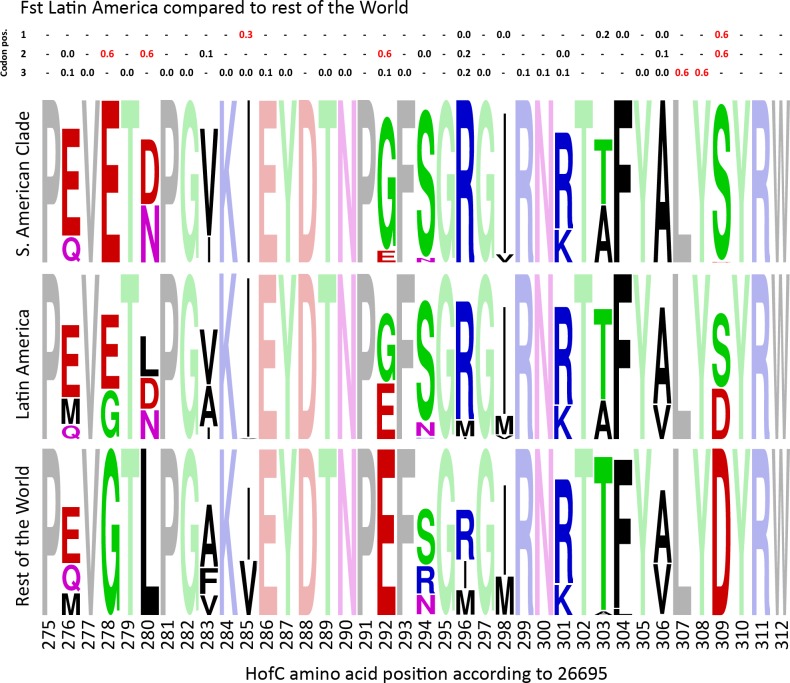
Fst values and WebLogo representations for amino acids 275–312 of HofC.The upper rows are Fst values for the triplets of nucleotides in each codon, calculated for isolates originating from Latin America compared to isolates from the rest of the world. WebLogo representations of the region are showed for i) the South American clade in Fig 4B, ii) All isolates from Latin America (for which the Fst was calculated), and iii) Isolates from the rest of the world. Shaded residues are synonymous in all three populations.